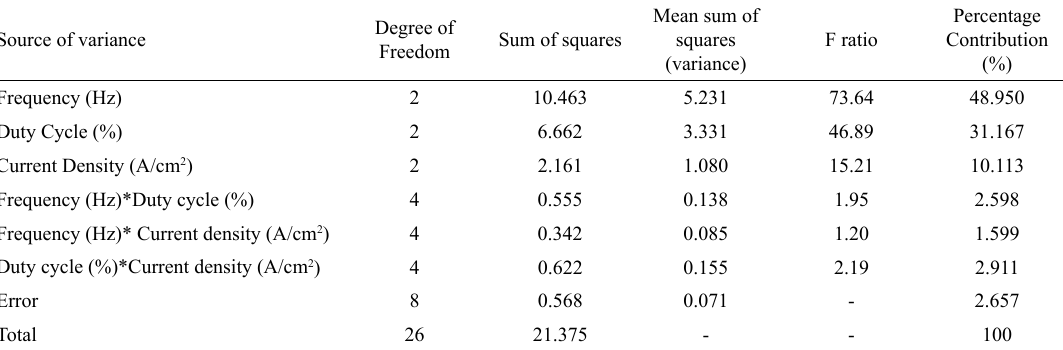
O composite. 2 3